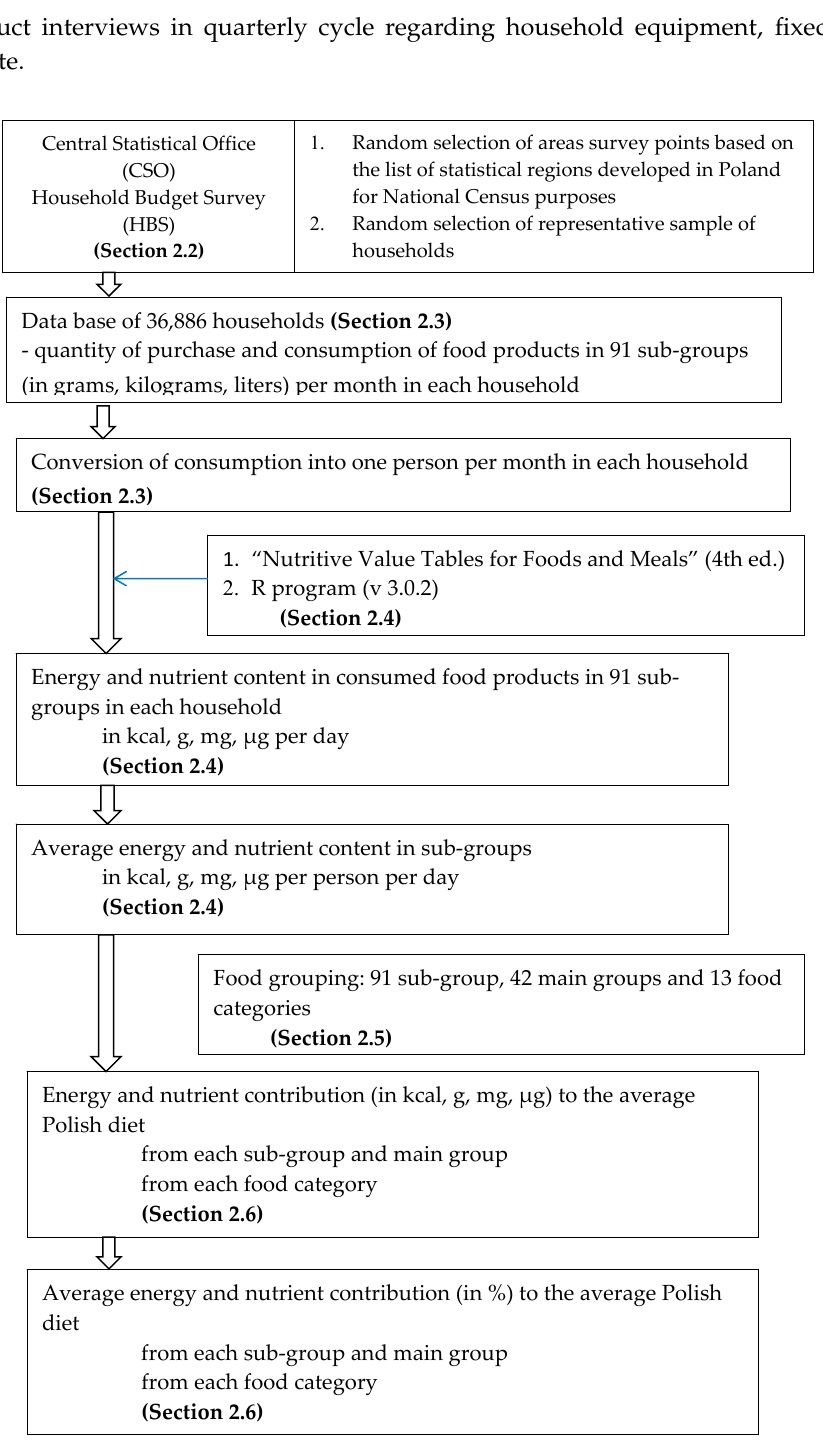
Figure 1. Research Figure 1. Research process.